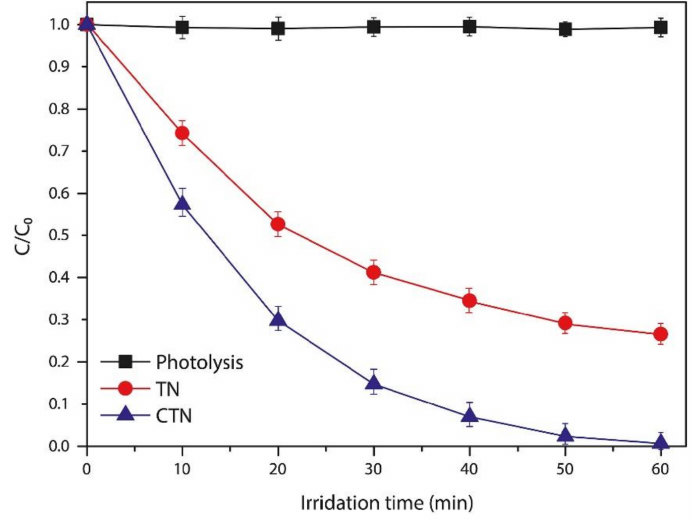
Figure 12. Photocatalytic degradation of RhB dye with UVA irradiation by un-doped (TN) and Cr-decorated photoanodes. Reprinted with the permission from reference [31].